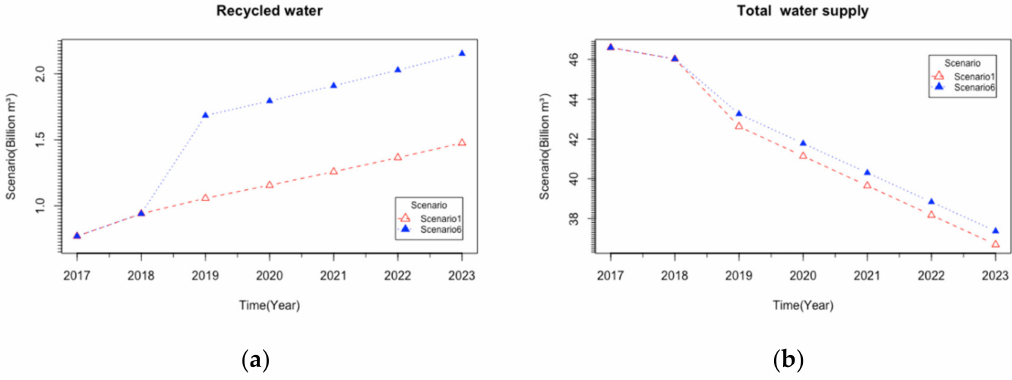
Figure 13. Scenario 6 simulation results: ( a ) Trend of recycled water; ( b ) Trend of total water supply.